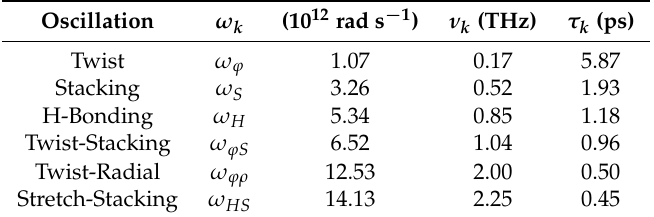
Table 2. Characteristic frequencies and scale times in the lattice dynamics of dsDNA polyG-polyC homopolymers. The ν ϕρ , ν ϕ S , and ν HS values for polyA-polyT homopolymers are slightly smaller by just about 4